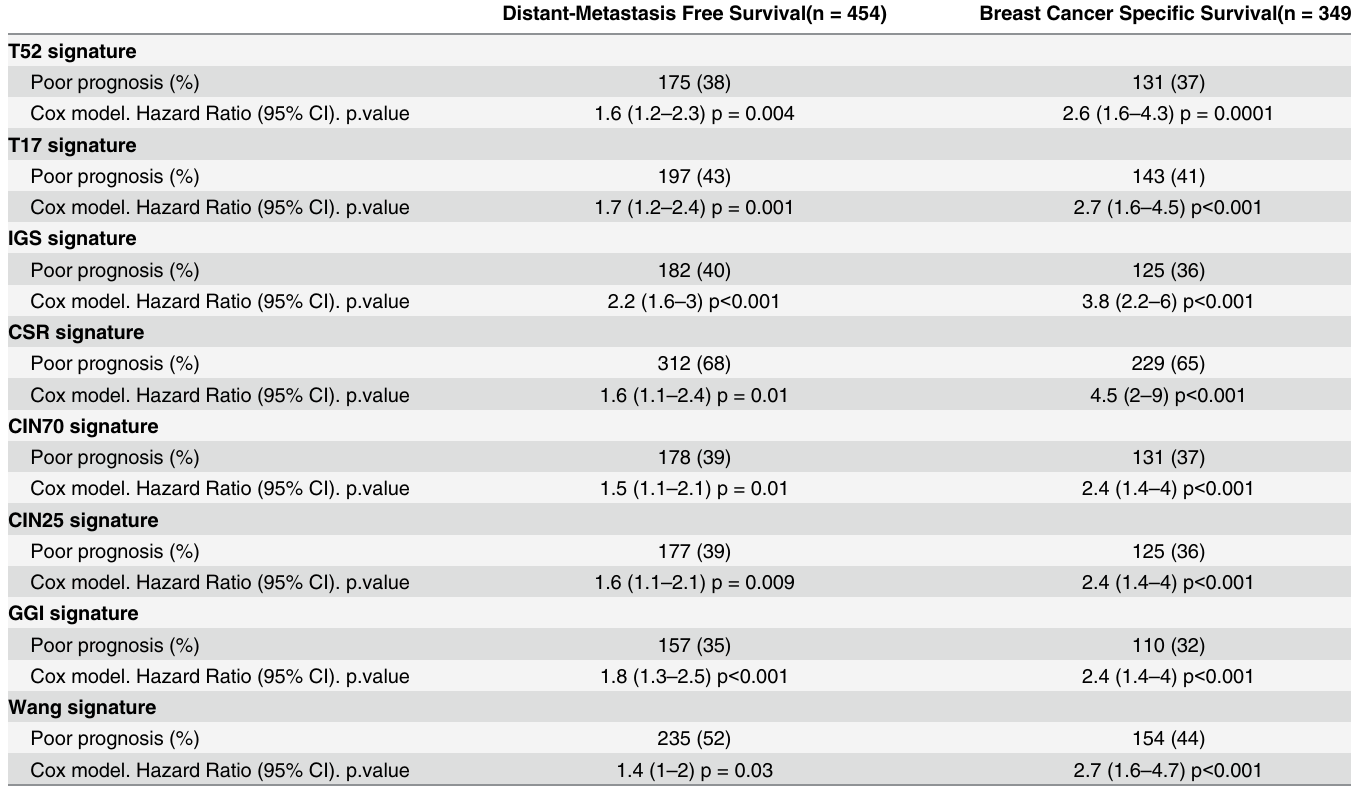
Table 2. Gene expression signatures performance in the prediction of Distant-Metastasis Free Survival and Breast Cancer Specific Survival * . Distant-Metastasis Free Survival(n =